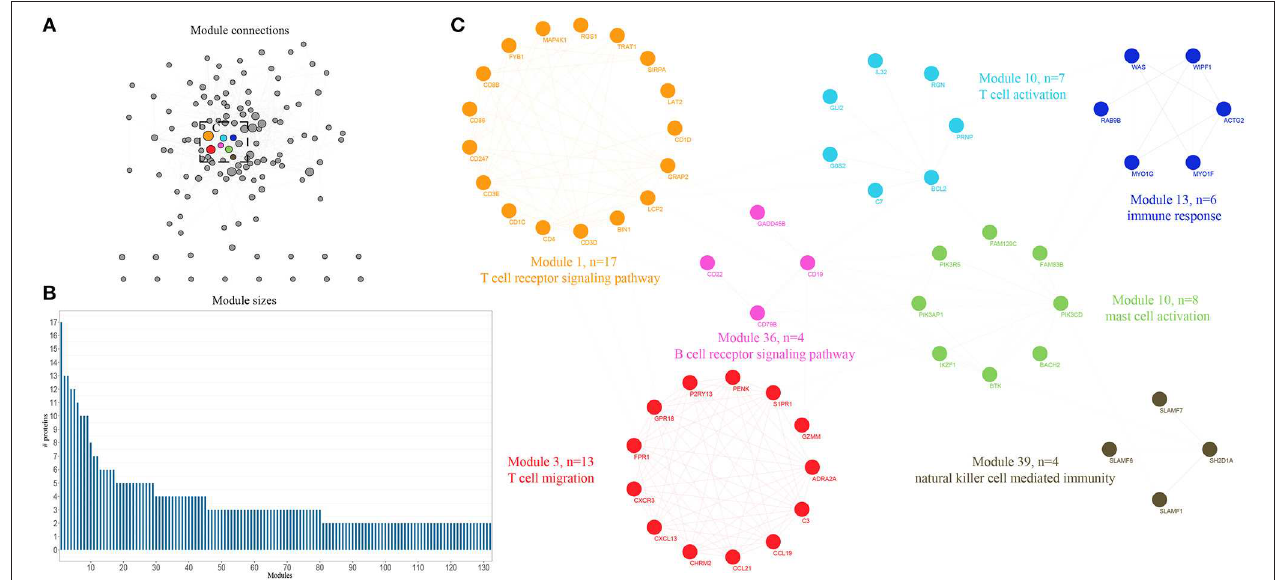
FIGURE 2 | Expression profiling of whole proteome reveals co-expression clusters and functional modules in bladder cancer. (A) Allocation of 132 modules. Each node represents the individual module and their interactions by the module size. Edges connect modules that share PPIs. Boxed modules are further enlarged in (C) . (B) Distribution of modules size, modules were identified by superimposition of proteins in bladder cancer onto the PPI network. The numbers of members from each module are exhibited in the figure. (C) Seven interconnected modules of immune reaction system derived from bladder cancer, with showing the protein names and representative functional